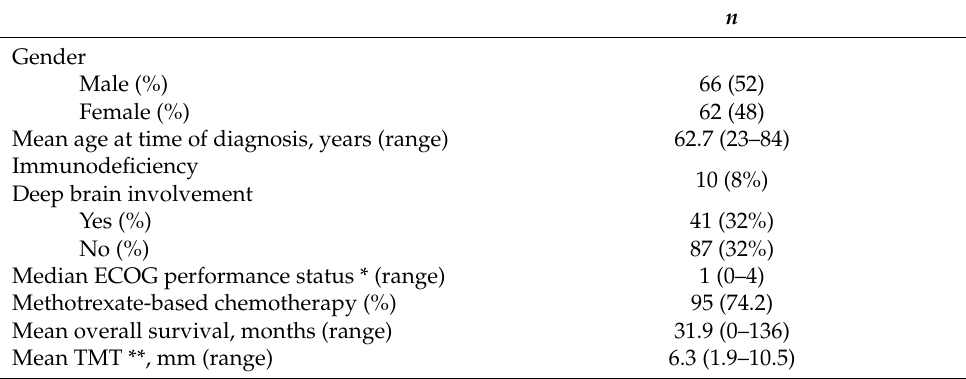
Table 1. Overview of patient